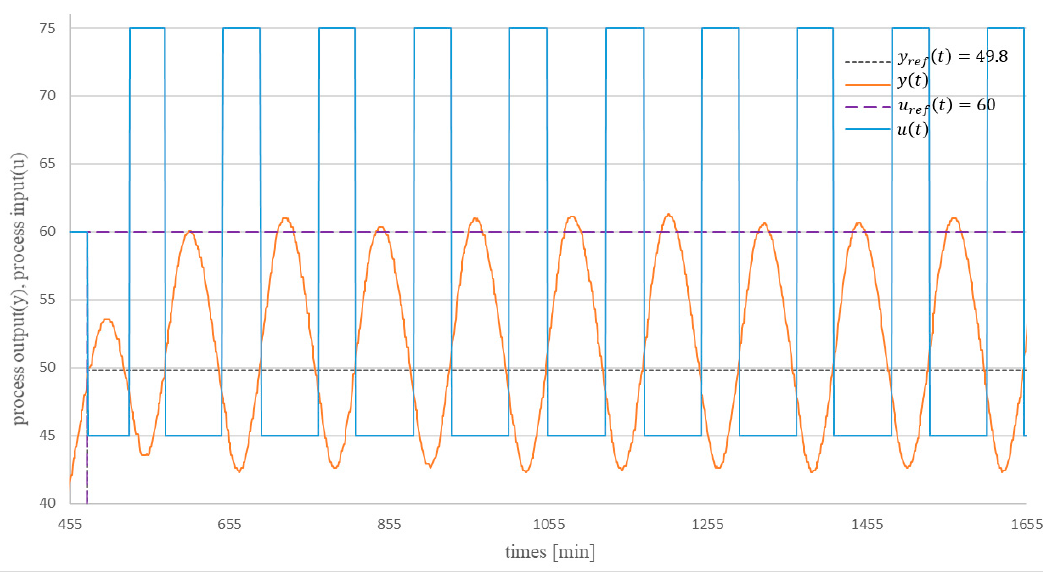
Figure 23. Convergence pattern of the relay feedback method [1].